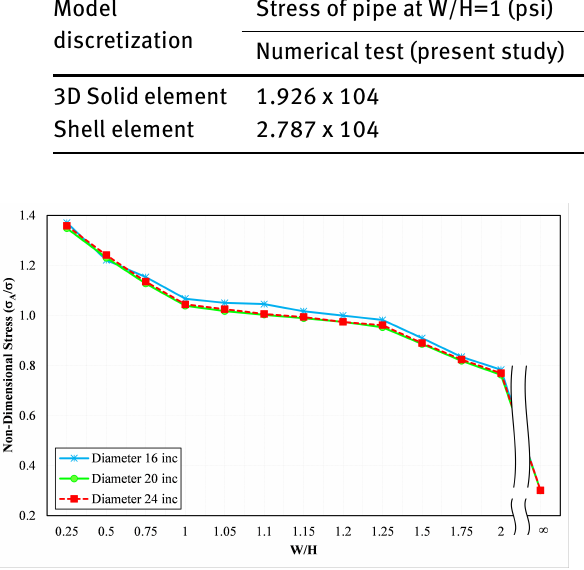
Figure 5: Relationship between σ A / σ with W/H of Expansion Loop at 400 o F temperature.